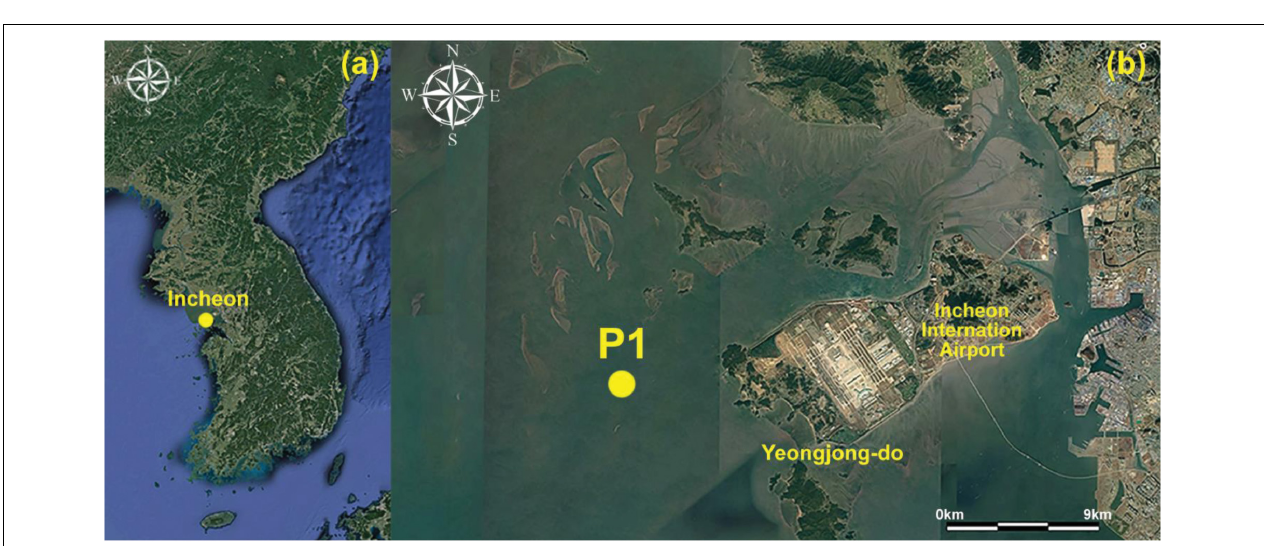
differences between the first (top) and fourth (bottom) layers during the spring tide. The current speed of the top layer ( z < 5 m) reached ∼ 1.4 m/s in the ebb and flood phases during the spring tide ( Figures 12b,c ). However, the maximum current speed of the bottom layer was only ∼ 0.8 m/s at z ∼ 15 m, which indicates the stratification of water during the spring tide.